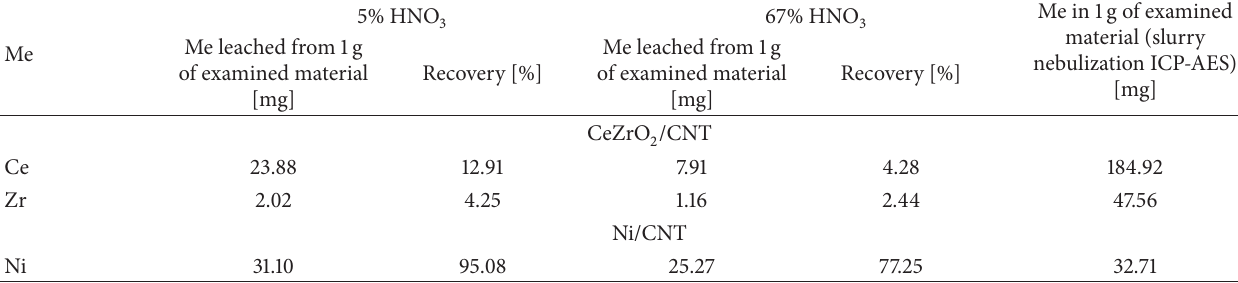
Table 4: Leaching of Ce, Zr, and Ni from hybrid Ni/CNT and CeZrO 2 /CNT materials (leaching medium—5% and 67% HNO 3 ).